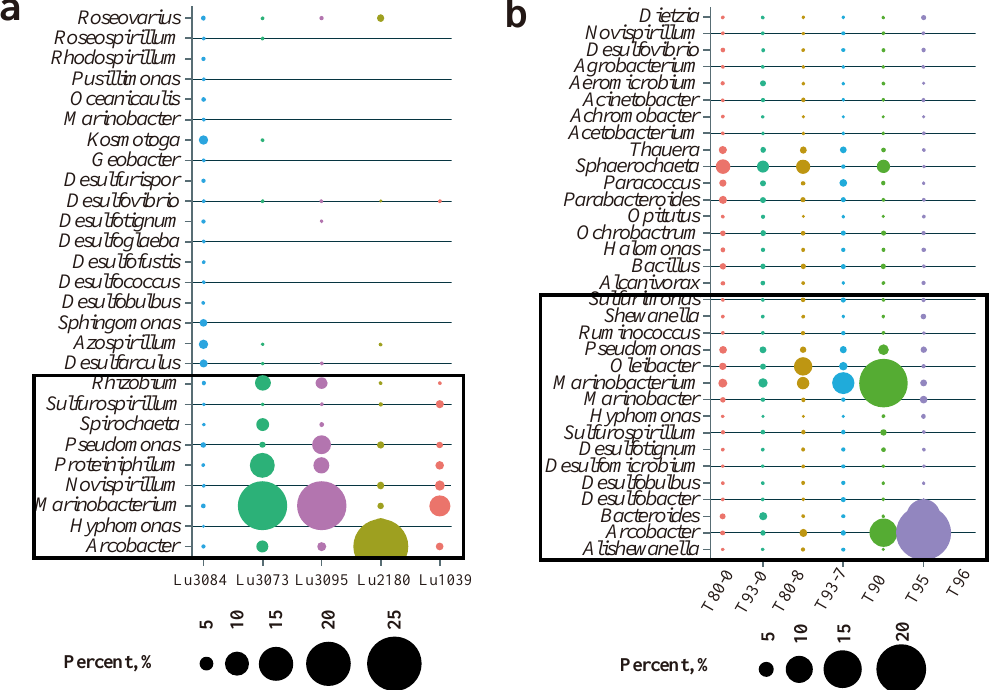
Figure 5. Genera showing the most variability in the injected water and production wells. (a) Sandstone and (b) conglomerate reservoirs. The black-bordered box indicates the genera most detected in the production